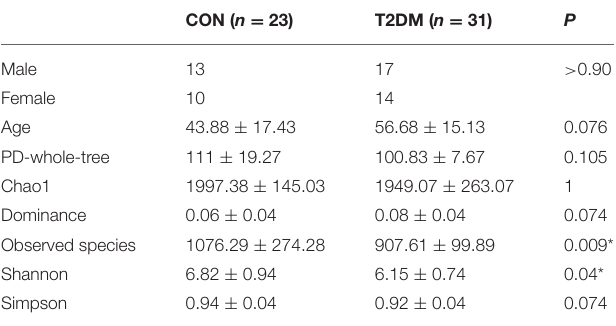
TABLE 1 | Illumina sequencing and statistical